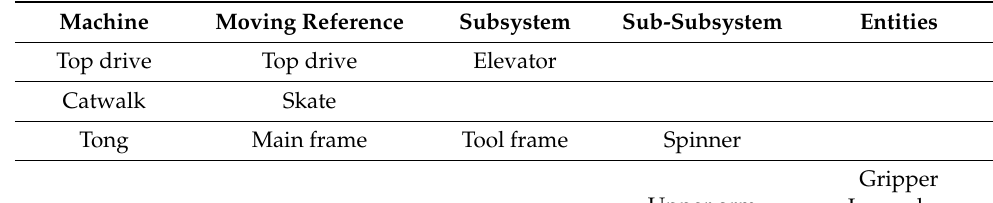
Table 1. Hierarchy of the drilling machines on the drill floor.